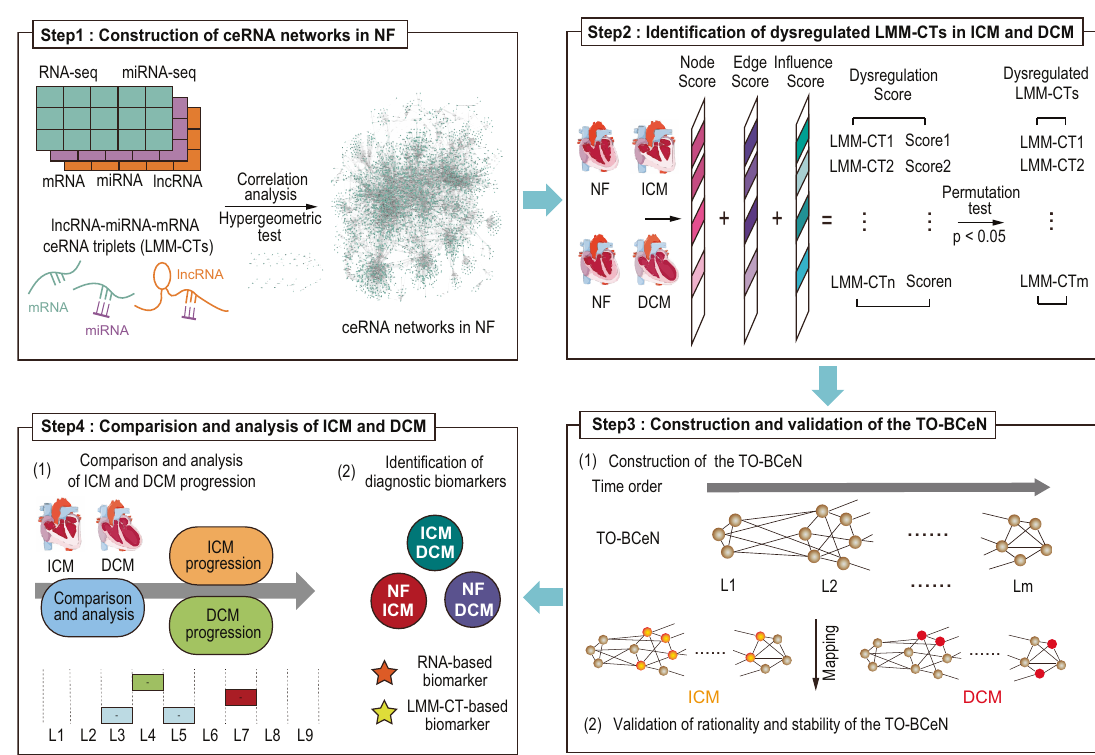
Fig. 1 Work fl ow of the present study. Step 1: CeRNA networks in NF were constructed using sample-matched RNA-seq and miRNA-seq data and experimentally supported interaction information. Step 2: Dysregulated LMM-CTs in ICM and DCM were identi fi ed applying our method, which integrated the dysregulation extent of gene expression, gene interactions, and the in fl uence of the dysregulated LMM-CTs. Step 3: TO- BCeN in NF was constructed based on the breadth- fi rst algorithm. After mapping dysregulated LMM-CTs of ICM and DCM to the TO-BCeN, its rationality and stability were veri fi ed. Step 4: The disease progressions of ICM and DCM were compared based on the TO-BCeN, and diagnostic biomarkers for ICM and DCM were identi fi